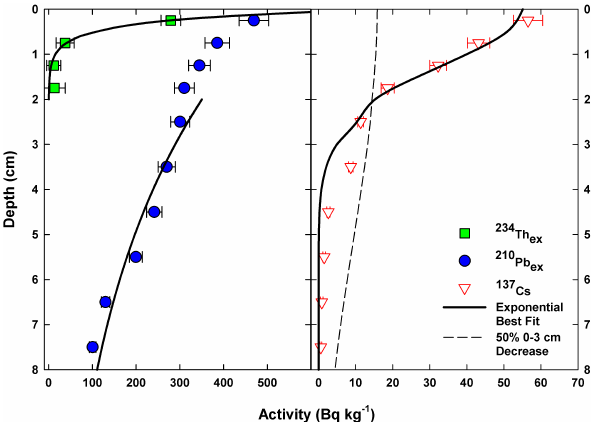
Figure 4. Example model best-fit regressions for 210 Pb ex , 234 Th ex , and 137 Cs for core 9. Mixing rates derived from the 210 Pb ex . 234 Th ex profiles in the left panel were used in the cesium pulse model for the right panel. In general, the model similarly fit the pro- files from the MCZ, OZ, and AZ. Model fits for the SCZ and NCZ were less successful due to almost vertical profiles for some